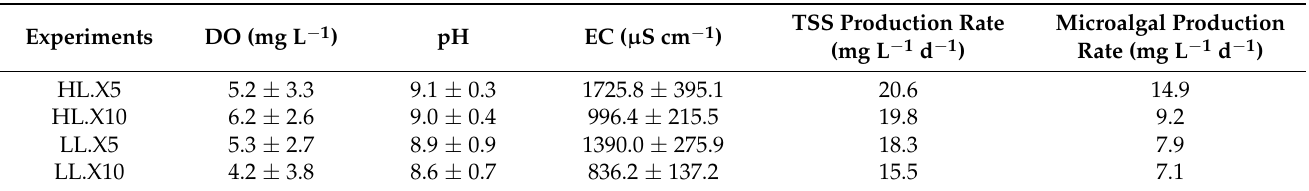
Table 4. Average values of physicochemical parameters (with standard deviations) and biomass production rate under the impacts of light and nutrient